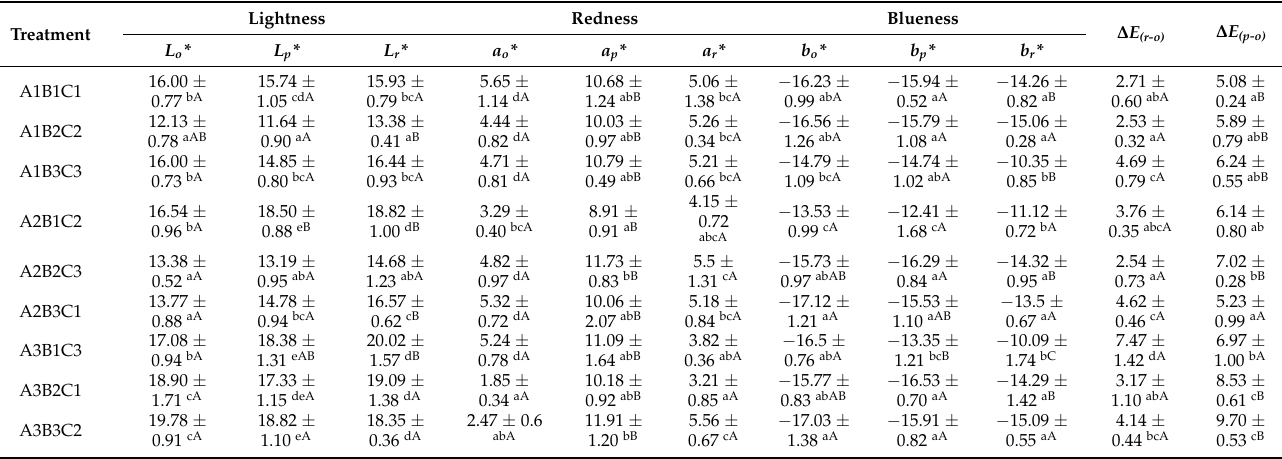
Table 1. Effects of different electrospinning process conditions on the instrumental color values of the